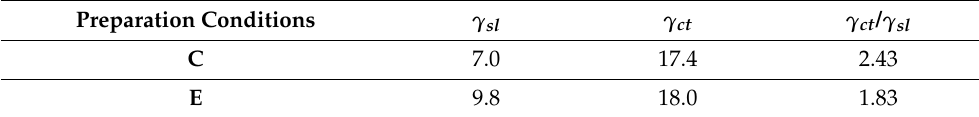
Table 3. Inhibition coefficients for samples prepared in modes C and E